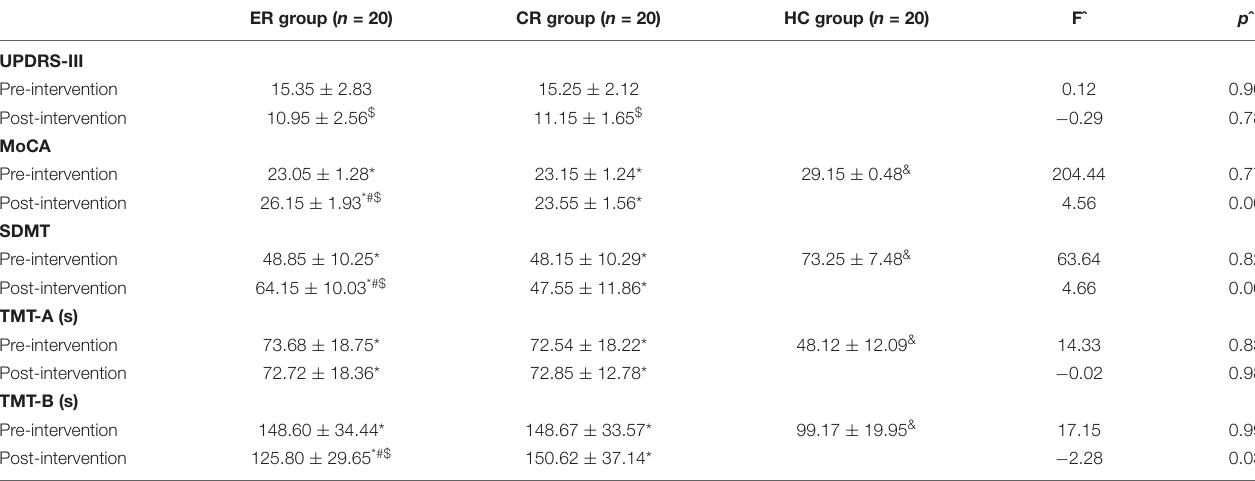
TABLE 3 | Motor and cognitive assessments for all participants pre- and